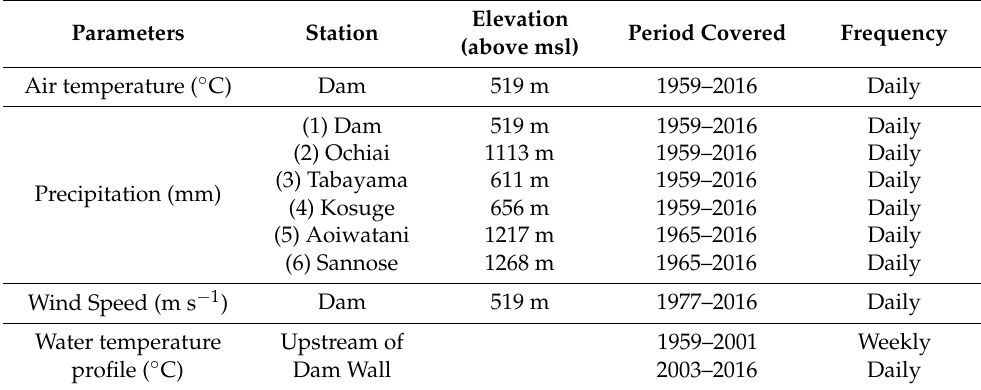
Table 1. Long-term observational data of climate and reservoir temperatures.